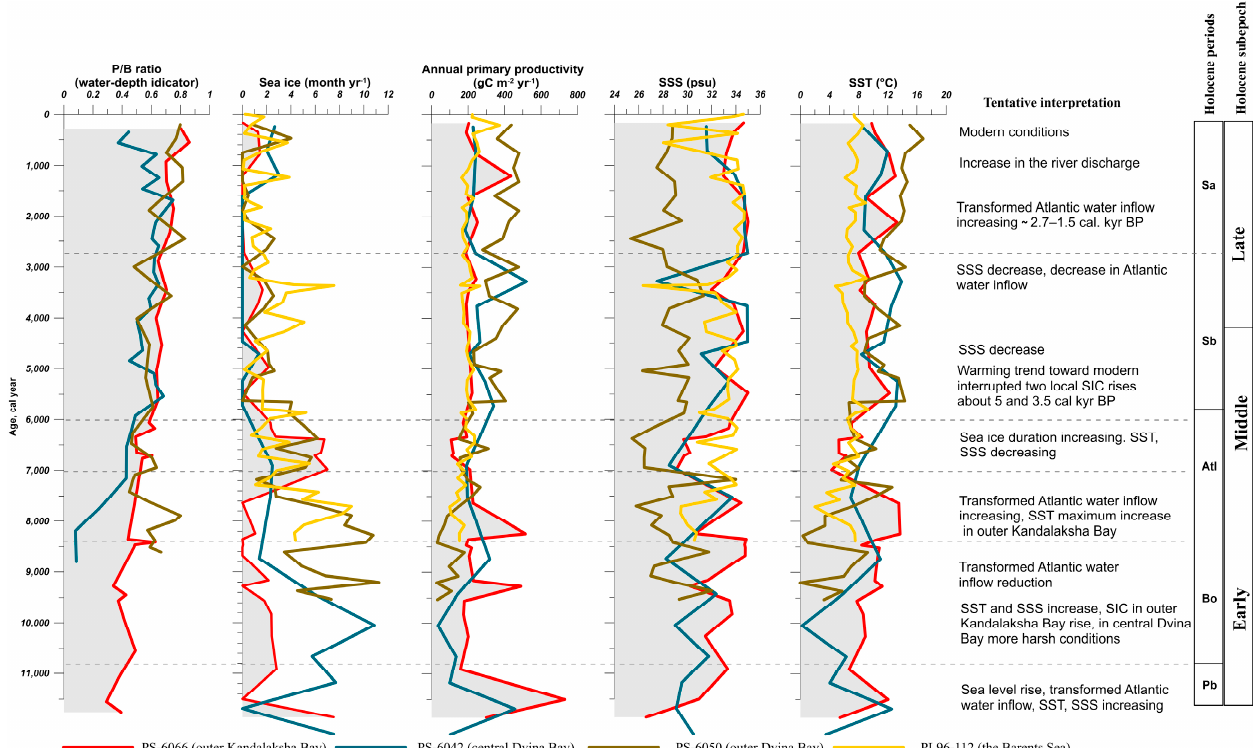
Figure 7. Diatom P/B ratio and quantitative estimates of sea surface parameters in the White Sea (this study) in and the Barents Sea (PL 96-112 by [23]). The Kandalaksha Bay is additionally highlighted by gray.